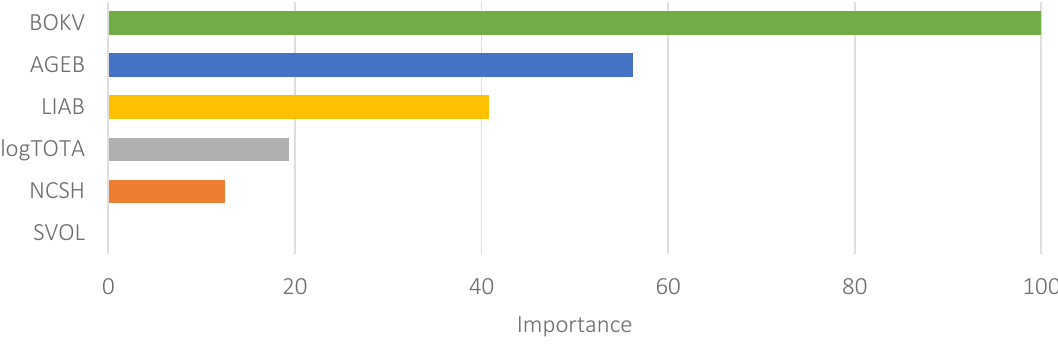
Figure 4. Basic regression tree variable importance scores for EPS model